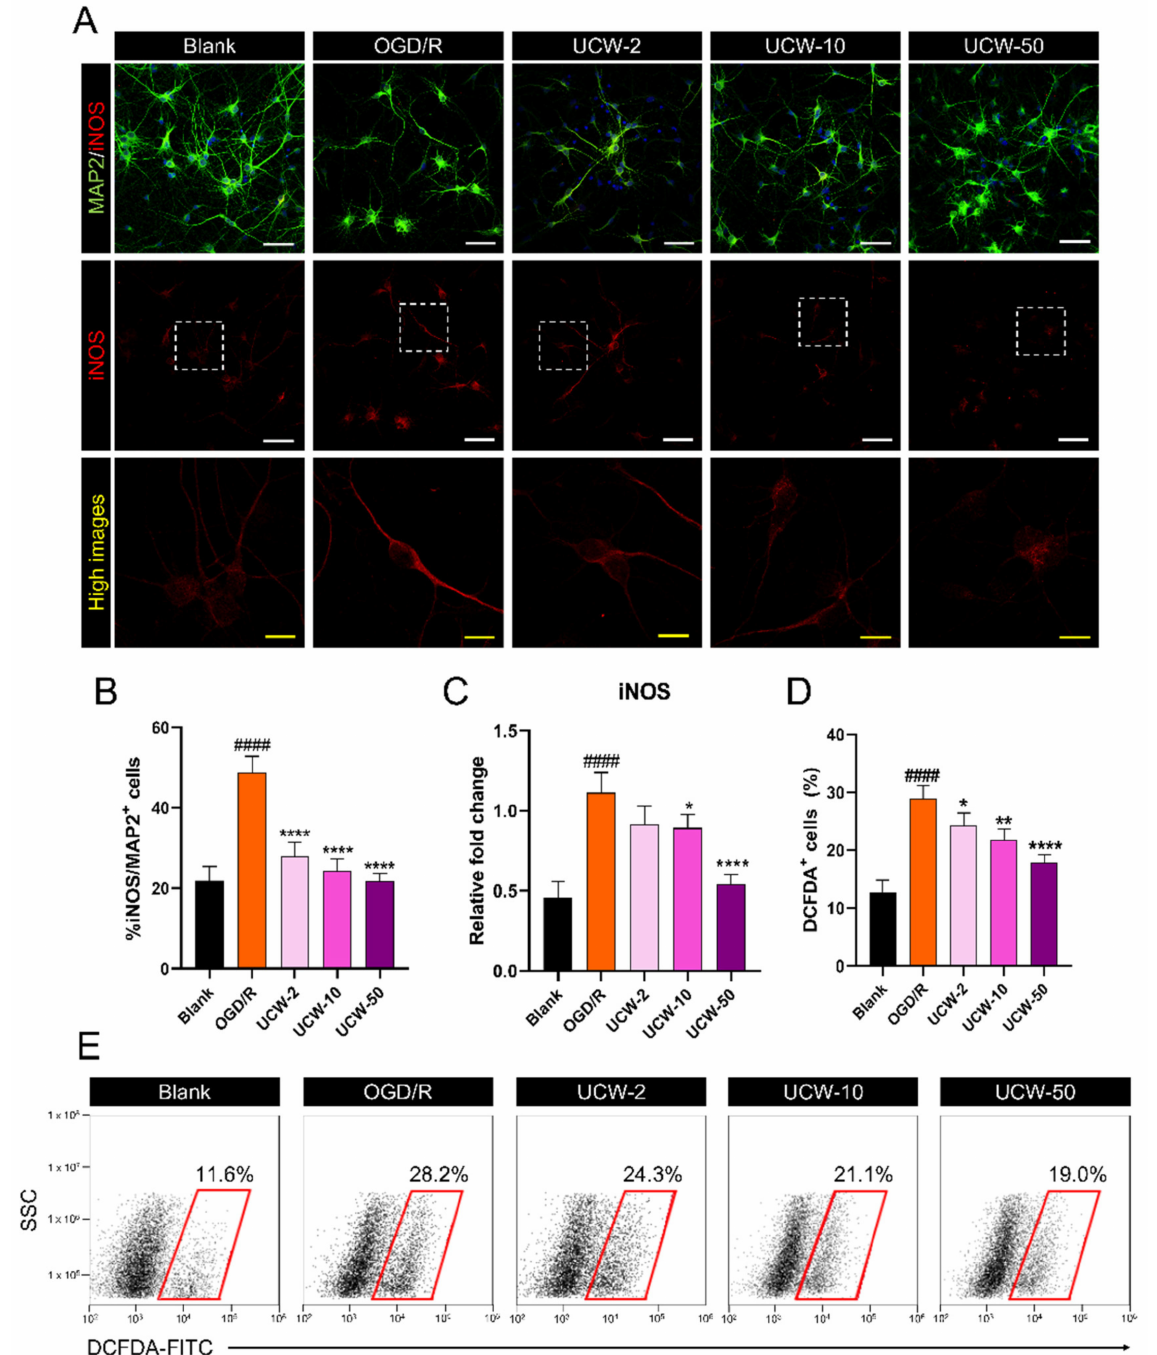
Figure 2. Antioxidant effect of UCW against OGD/R-induced oxidative injury via inhibition of iNOS- mediated ROS signaling. ( A ) Representative images of immunocytochemistry for MAP2 (green) and iNOS (red) in blank, OGD/R injury, UCW + OGD/R injury. White scale bar = 50 µ m, yellow scale bar = 10 µ m. ( B ) Quantitative analysis of iNOS+/MAP2+ cells estimated based on counts obtained from 10 non-overlapping fields in each group ( n = 10). ( C ) The relative gene expression levels for iNOS mRNA using real-time PCR in each group ( n = 4). ( D ) The percentage of H 2 DCFDA + cells in each group by flow cytometry ( n = 4). ( E ) Representative flow cytometry plot images of side scatter (SSC) versus H 2 DCFDA-FITC staining for intracellular ROS levels. Data are expressed as the mean ± SEM. Significant differences were analyzed via ordinary ANOVA with Tukey’s post-hoc analysis as follows: #### p < 0.0001 vs. blank group; * p < 0.05, ** p < 0.01, and **** p < 0.0001 vs. OGD/R